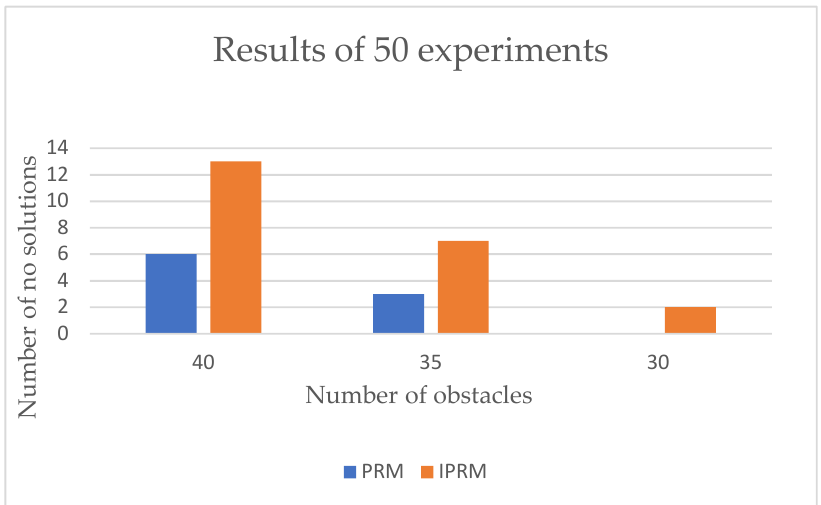
Figure 14. Results of 50 experiments with different number of obstacles.